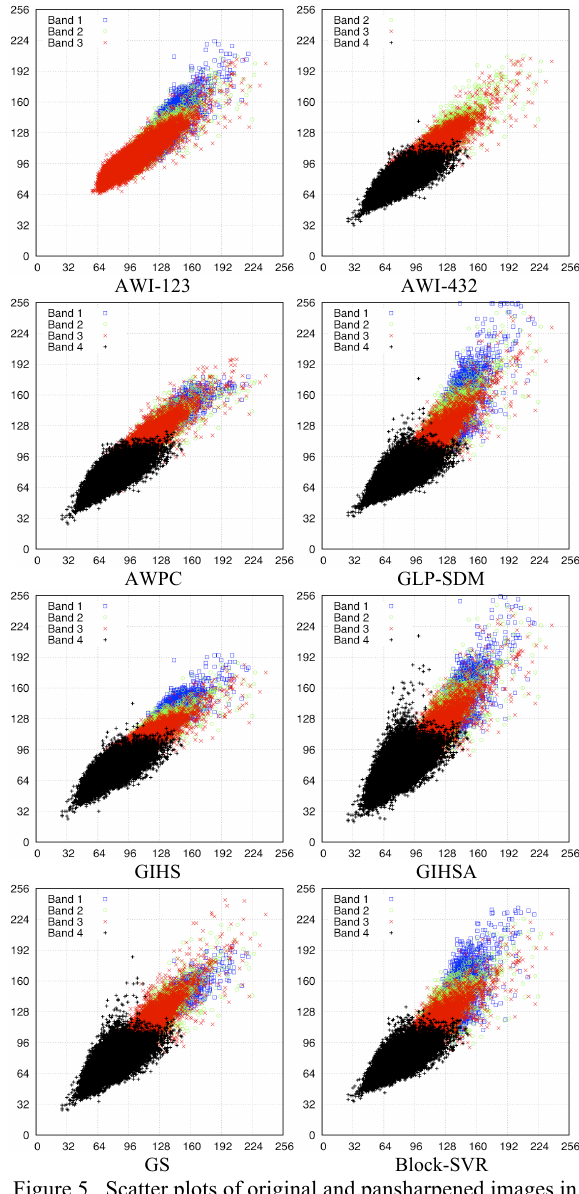
Figure 5. Scatter plots of original and pansharpened images in an agricultural area (horizontal: original, vertical: